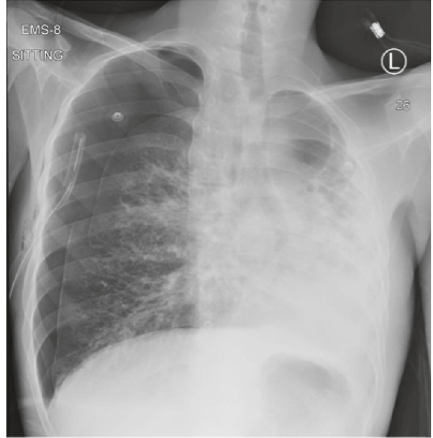
Figure 2: Chest X-ray after insertion of the chest tube showing improvement in the right-sided pneumothorax with subcutaneous emphysema.